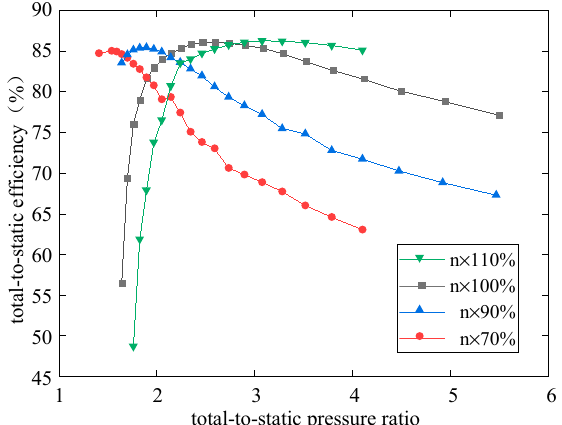
Figure 10. Performance curves of total-to-static efficiency to expansion ratio at 70–110% nominal rotational speeds.